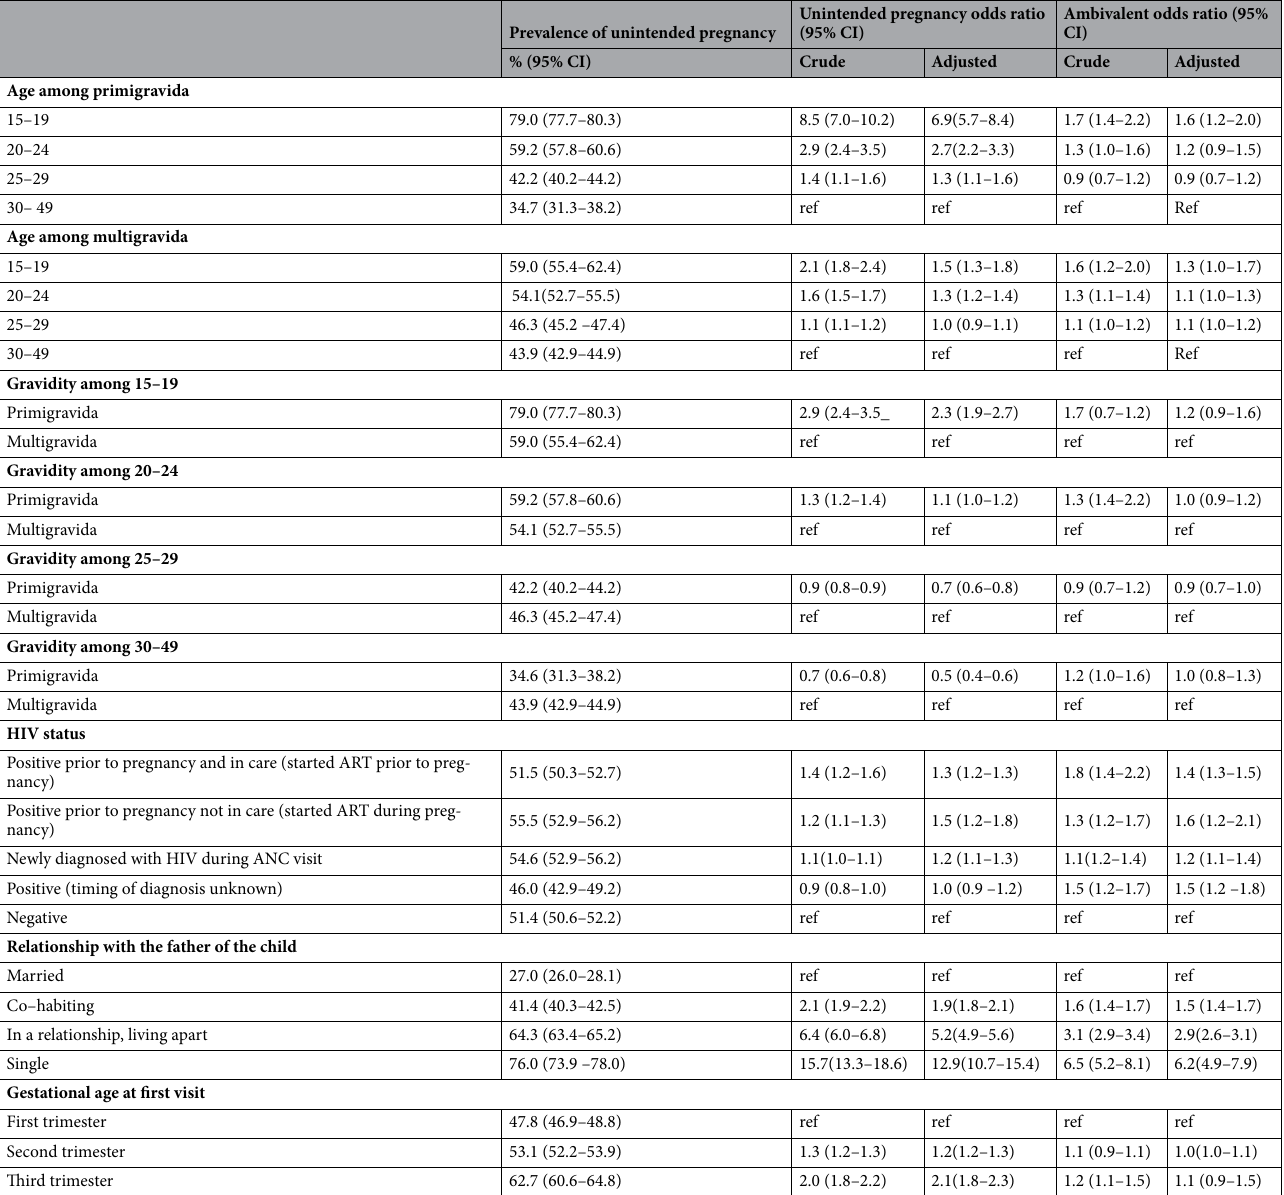
Table 3. Demographic and clinical characteristics associated with unintended and ambivalent pregnancy in the 2019 Antenatal HIV Sentinel Survey, South Africa (Reference group: Intended pregnancy). P value from Wald test for interaction term gravidity and age = < 0.01; Weighted analysis. Missing data excluded. N = 30,194 observations (86.4% of data) included in multivariable analysis. The above model was adjusted for the woman’s education